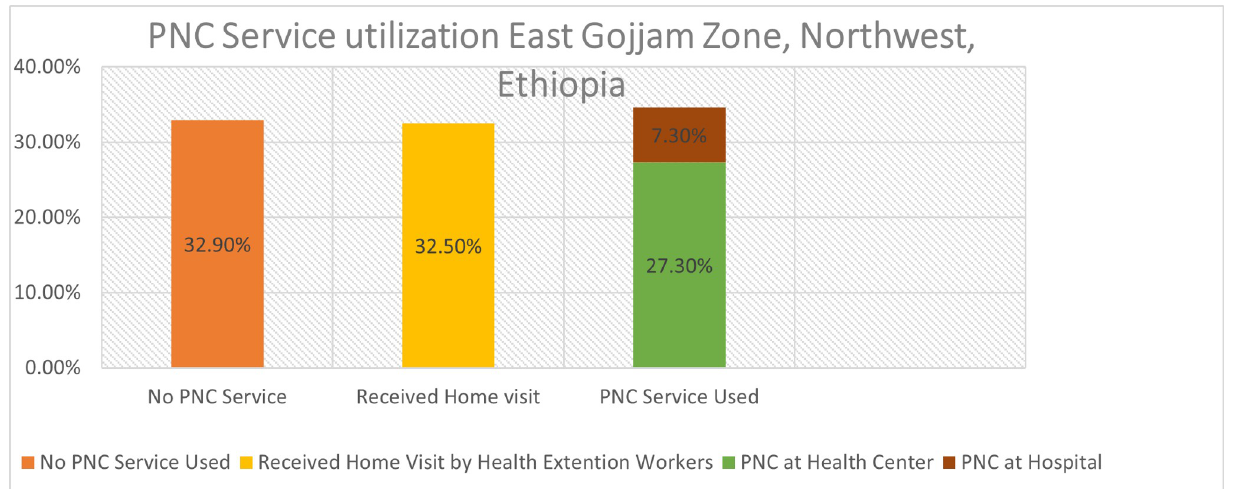
Fig 1. PNC Service utilization in East Gojjam Zone, Northwest Ethiopia.